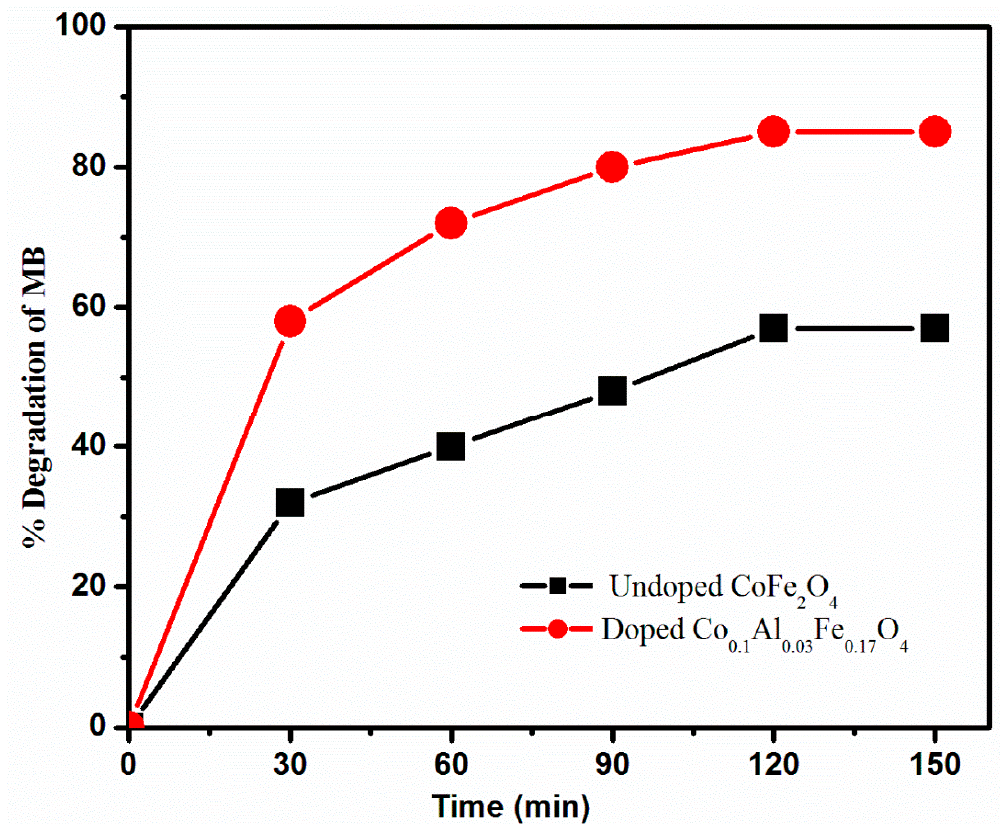
Figure 14. % degradation of MB dye by undoped and doped photocatalysts.